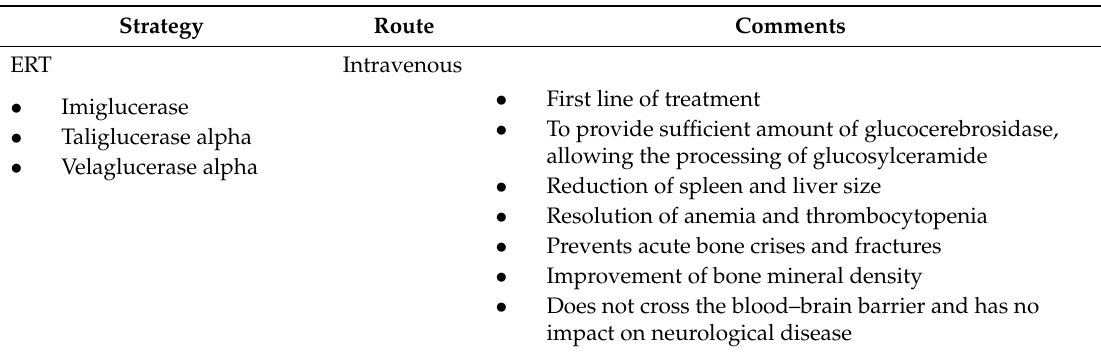
Table 2. Management strategies for neuronopathic Gaucher. ERT: enzyme replacement therapy; SRT: substrate replacement